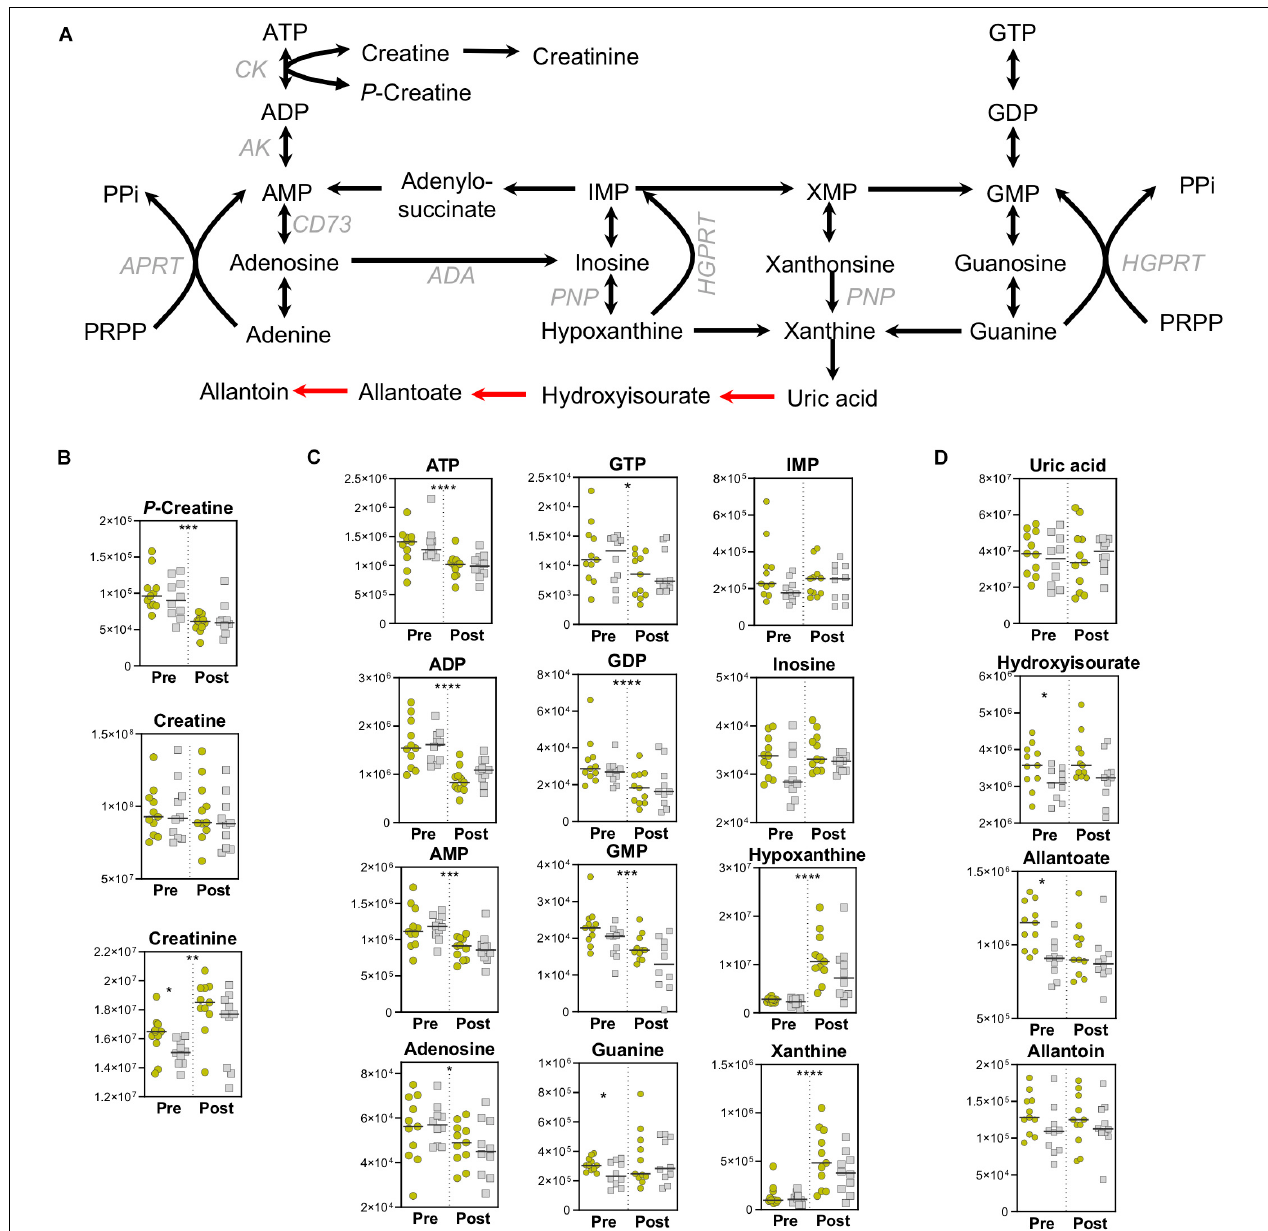
FIGURE 5 | High-Energy Phosphates and Purine Metabolism. (A) A pathway map for high-energy phosphate and purine homeostasis is shown. Spontaneous, non-enzymatic reactions are shown in red arrows. Metabolite abundances [ y -axis, Peak Area (AU)] are plotted for (B) Creatine homeostasis, (C) Purine salvage, and (D) Purine catabolism. Samples from the Gold ( ◦ ) and Silver ( (cid:3) ) groups are shown Pre and Post exercise test (divided by a dotted line). p -values from a two-tailed paired T -test of comparisons between the Pre and Post time points using combined Gold/Silver group values are shown above the dashed line. p -values from a two-tailed unpaired homoscedastic T -test comparing the Gold and Silver groups at each time point are shown on the respective side of the dashed line. * p < 0.05; ** p < 0.01; *** p < 0.001; **** p < 0.0001.